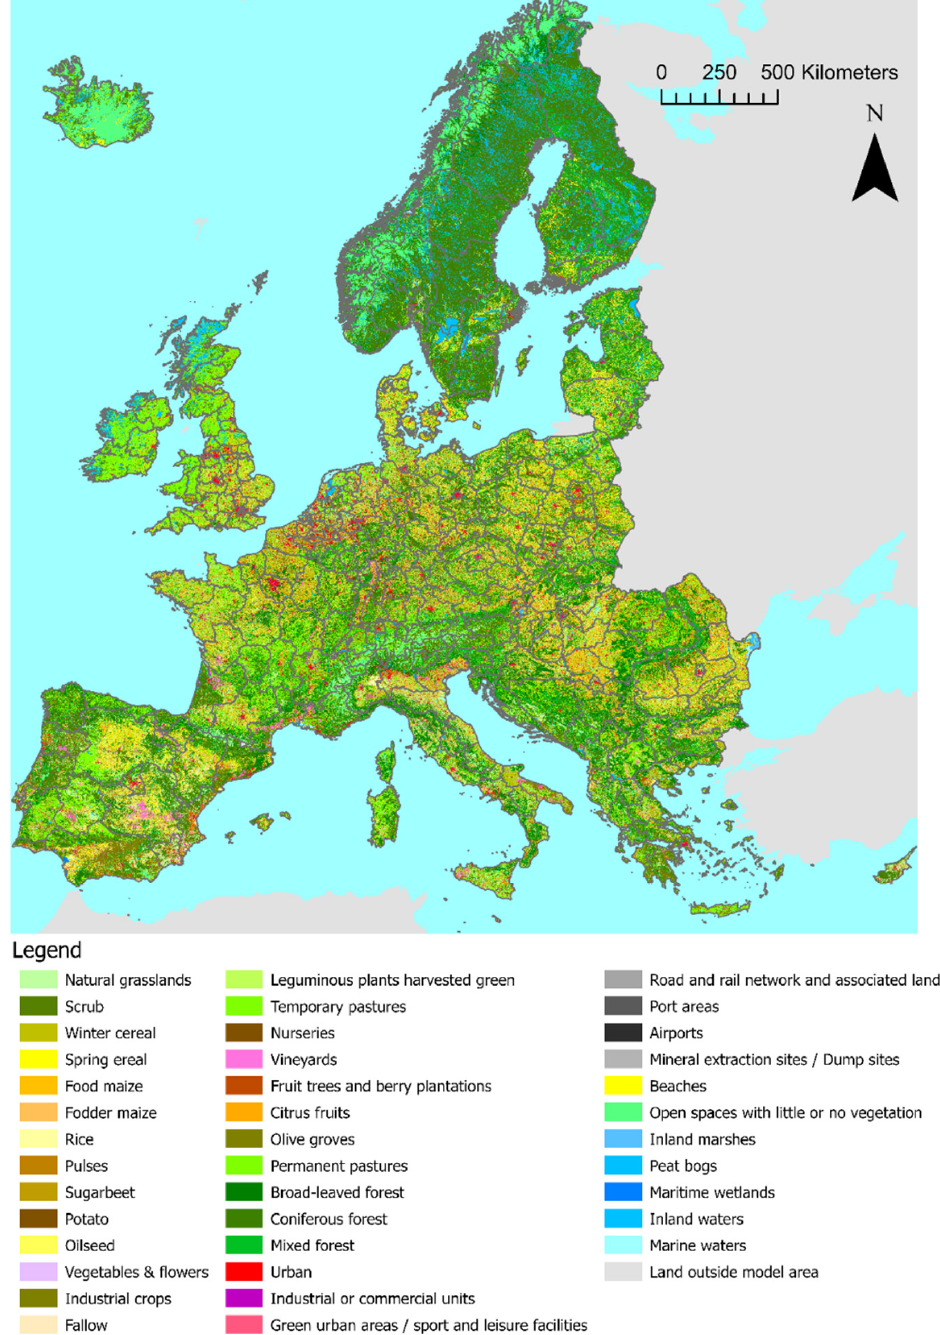
Figure 3. SoilCare land use and crop map (year: 2018). A GIS compatible version of this map is available in the supplementary material.